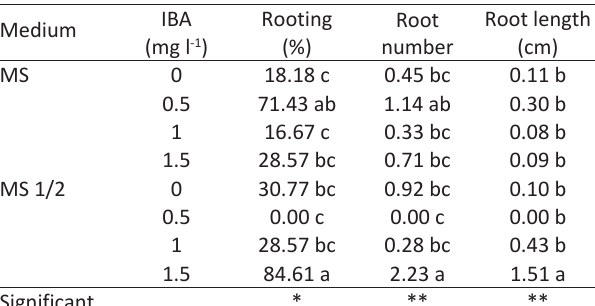
3 - Effects of different concentrations of IBA and media (MS and MS/2) on rooting characteristics in ‘Bargchenari’ genotype